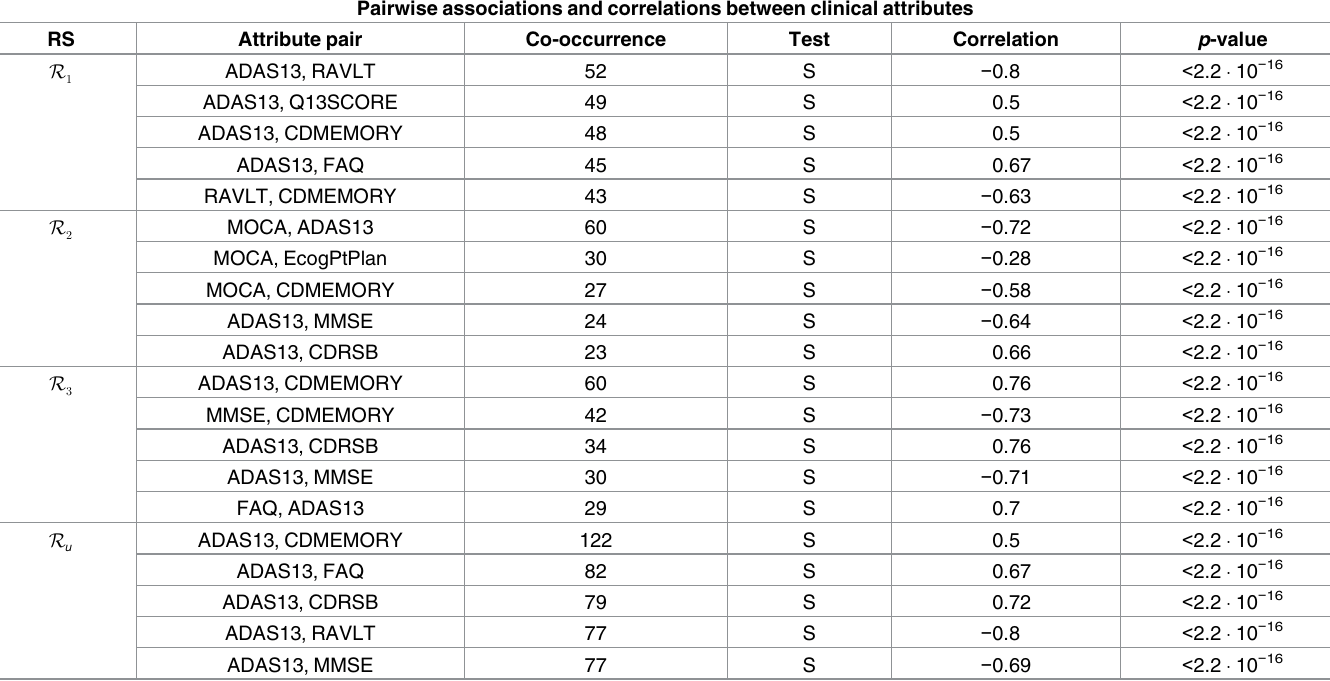
are computedon the largest dataset containing both attributes. u